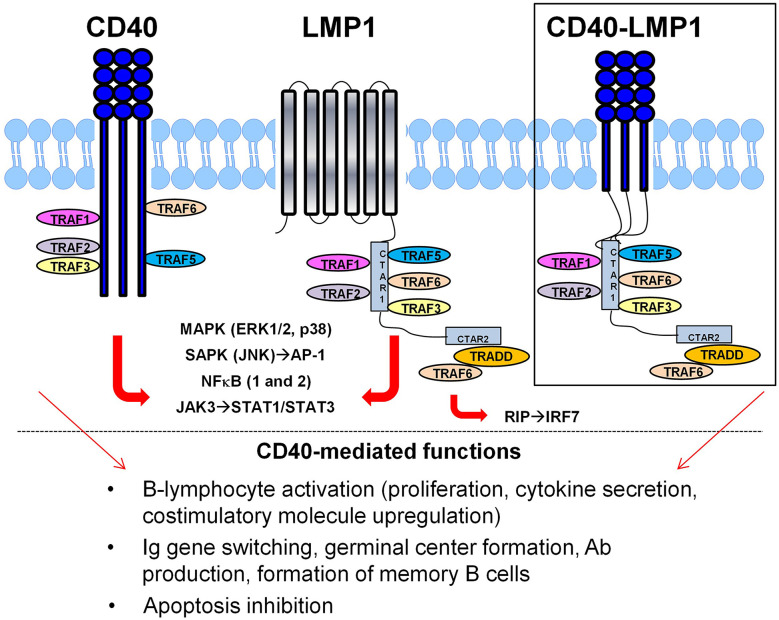
Latent Membrane Protein 1 (LMP1) acts as a viral mimic of the costimulatory molecule CD40. Similar to CD40, LMP1 binds TRAFs through its cytoplasmic domain to mediate proximal signaling/transcriptional regulation and downstream function, including B-lymphocyte activation, antibody production and isotype switching, and apoptosis inhibition. However, LMP1 does this in a dysregulated manner, partially through its ligand-independent, self-aggregating six-transmembrane domains. Replacing the extracellular/transmembrane domain of LMP1 with CD40 demonstrates that the cytoplasmic tail of LMP1 is necessary and sufficient for its enhanced and dysregulated functional mimicry of CD40 (inset).